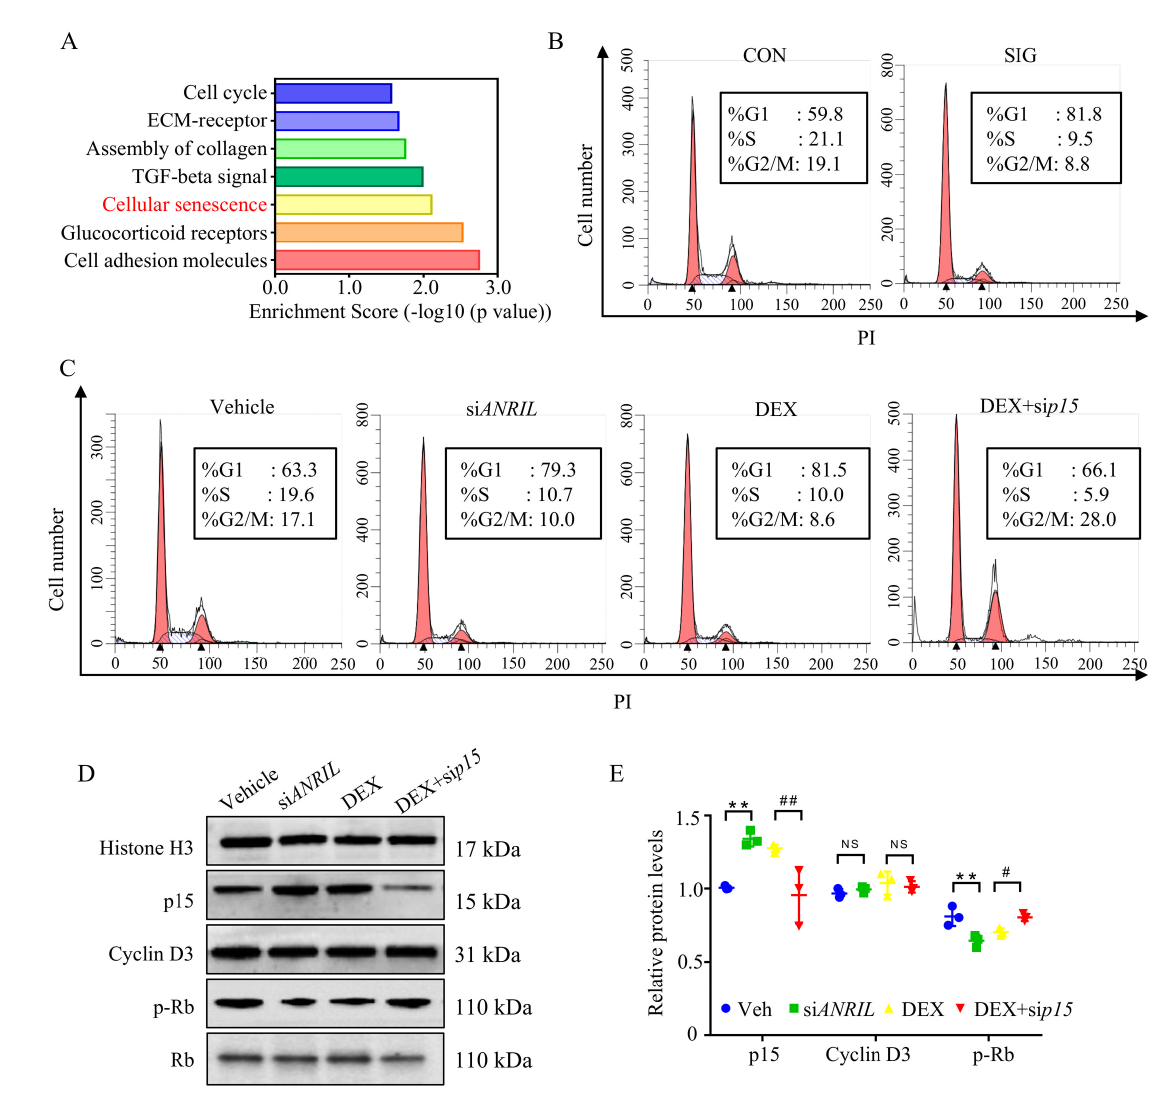
Figure 4. ANRIL/p15 regulates cell senescence in SIG. ( A ) Biological pathways participating in SIG were analyzed using Panther enrichment analyses. Disturbed genes in SIG TM samples compared to controls were enriched in the deposit of ECM and cellular senescence. n = 3 per group. ( B ) TM samples from control and SIG mice were prepared as single cell suspensions and labeled with PI for cell cycle analysis. In SIG TM samples, there was a huge increase of cells arrested in G1 stage and decrease in other stages. n = 5 per group. ( C ) In cultured mouse TM cells, DEX treatment induced G1 arrest by blocking more cells in the G1 phase compared to vehicle treated cells. ANRIL depletion also induced G1 arrest as DEX. Depletion of p15 prevented DEX induced G1 arrest. n = 6 per group. ( D ) In cultured mouse TM cells, the expression of p15 protein and Cyclin D3 protein was measured in nuclear protein fractions, while Histone H3 served as internal controls. The phosphorylated Rb protein was checked in cytoplasm fraction with total Rb protein as control. n = 6 per group. ( E ) Quantification of ( D ). Notes: CON = control; SIG = steroid-induced glaucoma; ECM = extracellular matrix; Veh = vehicle; siANRIL = ANRIL knock down; DEX = dexamethasone; sip15 = p15 knock down; ** p < 0.01 compared with vehicle; # p < 0.05 compared with scramble RNA; ## p < 0.01 compared with scramble RNA; NS = no significant